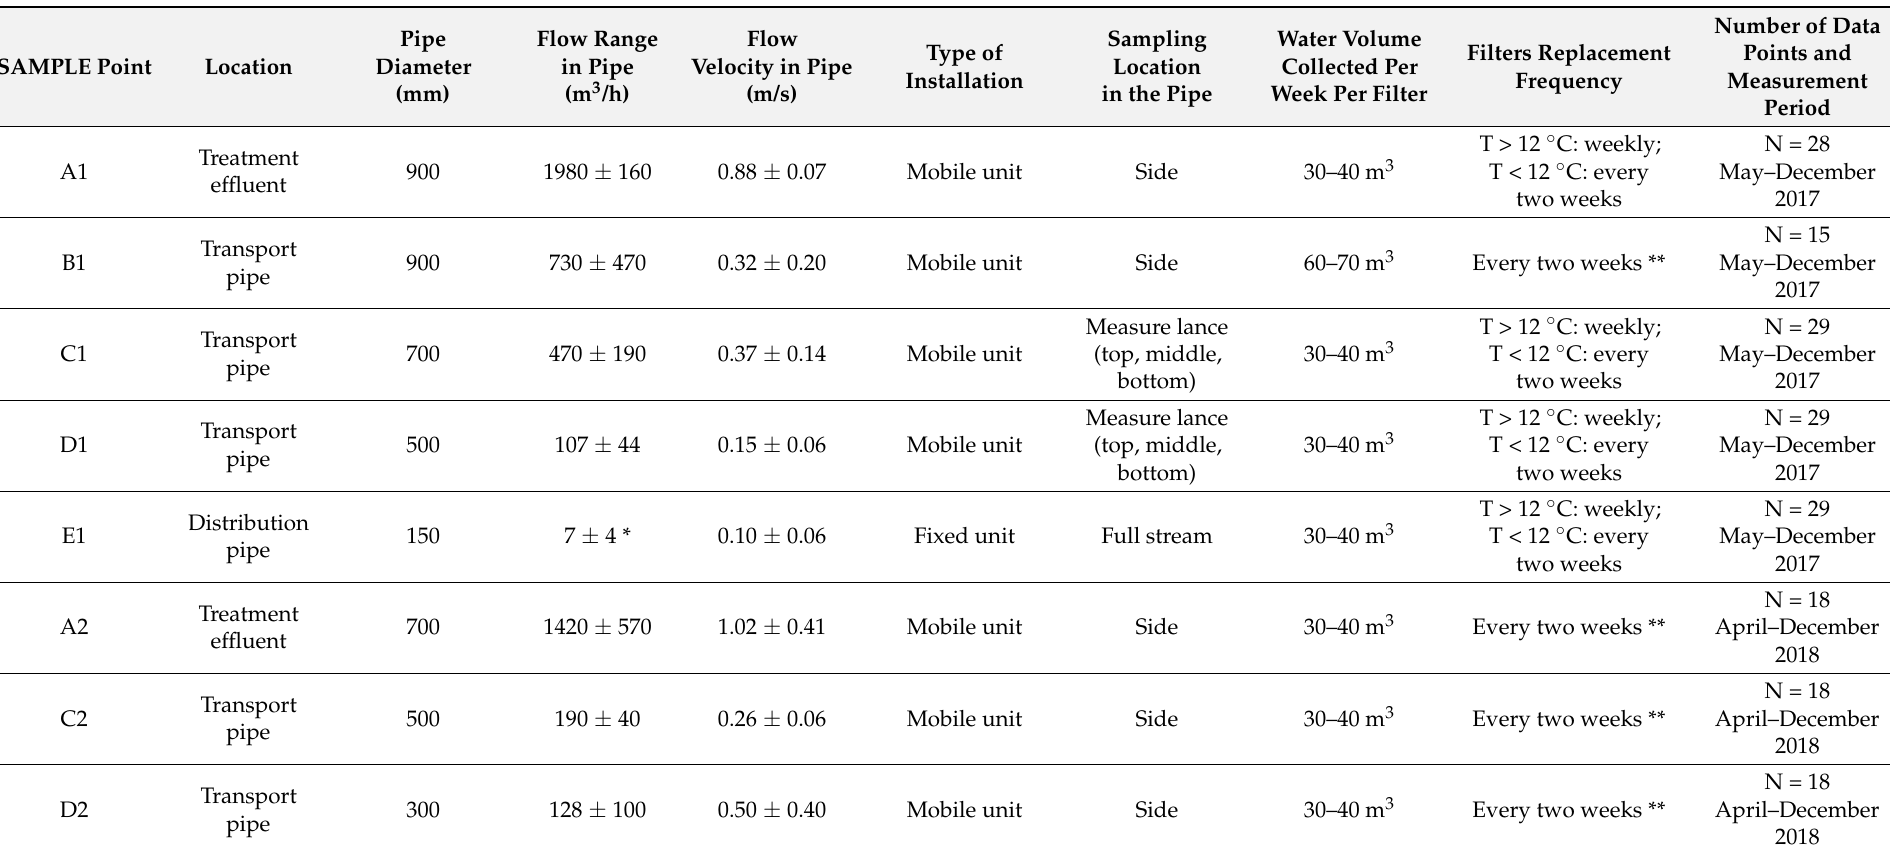
Table 1. Characteristics of sampling locations and filter installations for the evaluation of spatial variations in the study system (locations A1 to E1) and the reference system (locations A2 to D2) as described in Figure 2. For location E1, data from the 11-year data set was selected to cover the same time period as for locations A1 to